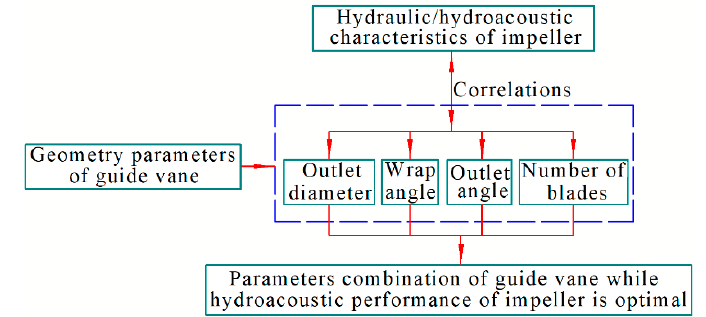
Figure 2. Research routes followed in this study.